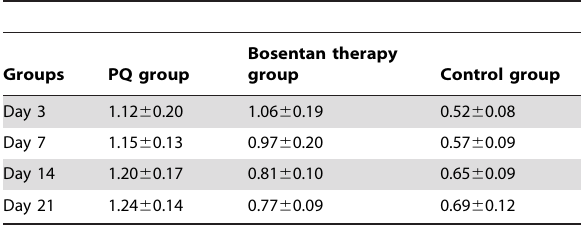
Table 5. Dynamic change of HYP in the lungs of the three groups (mean 6 SD, m g/mg).